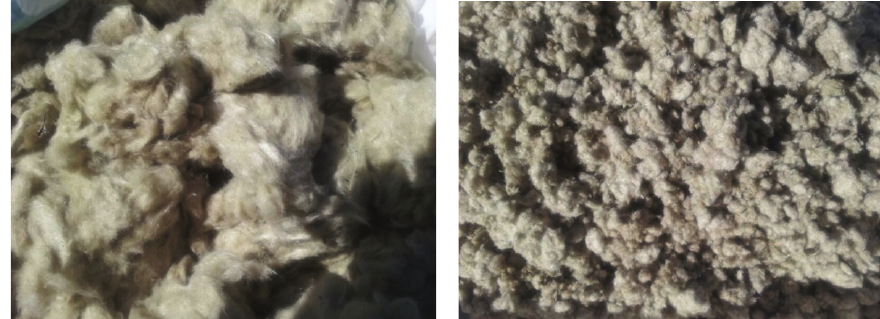
Figure 3: Rock wool recycling before and after being processed.